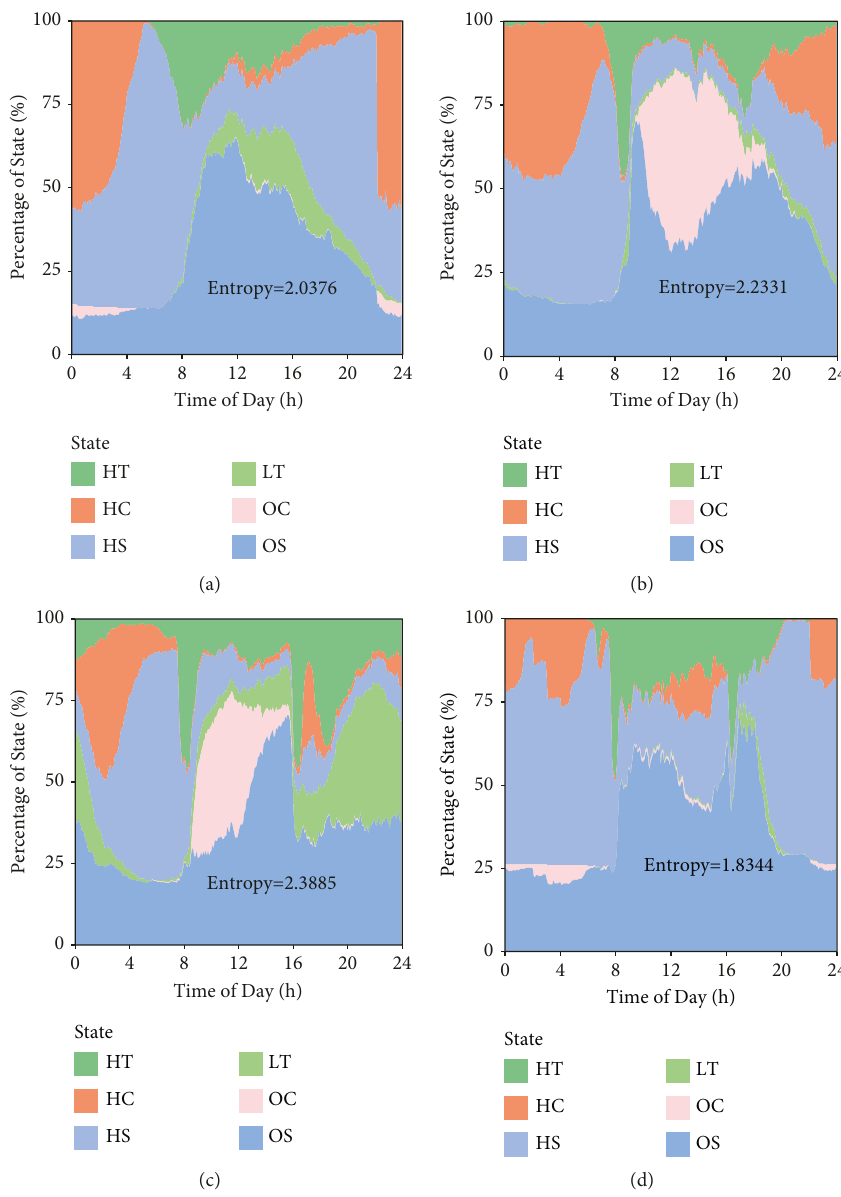
Figure 6: EV state distribution at different times of day. (a) EV user 1. (b) EV user 2. (c) EV user 3. (d) EV user